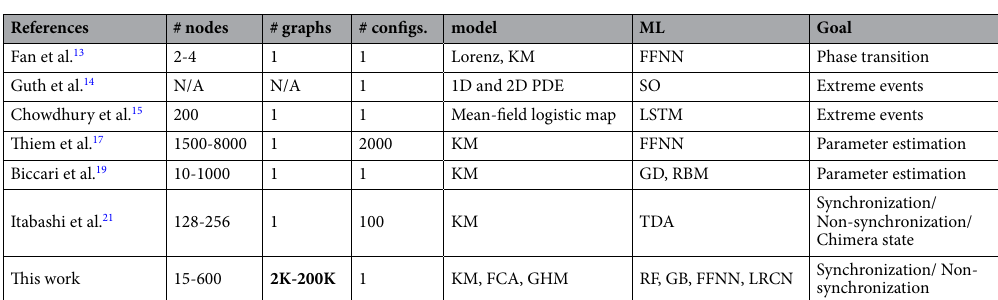
Table 1. Comparison of settings in related works on learning coupled oscillator dynamics using machine learning methods. Recent works in the table focus on learning features of dynamics on fixed graphs. In contrast, we aim to classify the long-term dynamics of a given system on a diverse set of underlying graphs. The column for ‘# configs.’ refers to the number of distinct initial phase configurations considered for each graph in